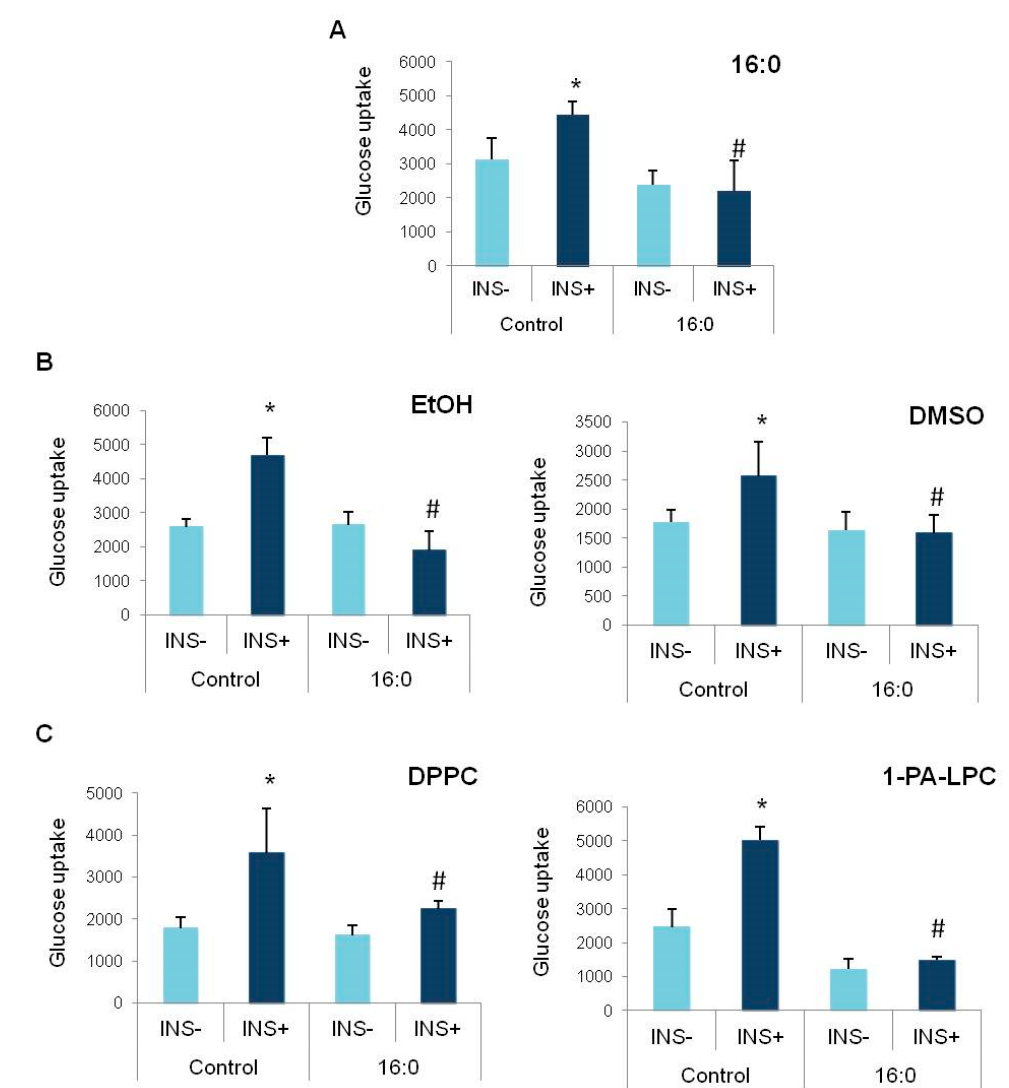
Figure 4. The insulin-stimulated glucose uptake after insulin resistance induction in 3T3-L1 adipocytes. ( A ) The confirmation of insulin resistance induction by palmitic acid (16:0), ( B ) the effect of solvents (ethanol and DMSO) on insulin sensitivity in control and insulin-resistant 3T3-L1 adipocytes, ( C ) the effect of functional compounds used for the synthesis of derivatives (DPPC and 1-PA-LPC) on insulin sensitivity in insulin-sensitive (control) and insulin-resistant (16:0) 3T3-L1 adipocytes, * statistical significance in relation to basal glucose uptake (INS − ), p < 0.05; # statistical significance in relation to insulin ‐ sensitive cells stimulated by insulin (Control INS+); Student’s t ‐ test, p < 0.05.